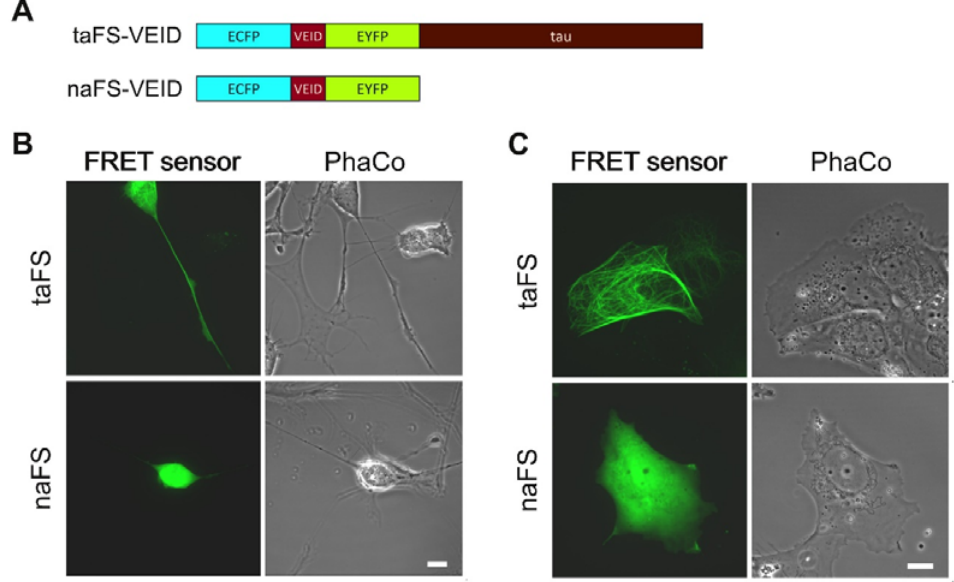
Figure 1. Anchoring enables monitoring of FRET sensors throughout the cell including thin processes. ( A ) Schematic illustration of an anchored (taFS-VEID) and a non-anchored (naFS-VEID) FRET sensors. Both sensors contain a tandem VEID sequence between ECFP and EYFP. naFS-VEID was generated by introducing a stop codon at the 5 ′ -end of tau-encoding sequence within the taFS-VEID cDNA; ( B ) Representative images of differentiated SH-SY5Y cells overexpressing taFS-VEID (upper panel) and naFS-VEID (lower panel); ( C ) Representative images of SK-N-AS cells overexpressing taFS-VEID (upper panel) and naFS-VEID (lower pannel). Note the absence of signal from taFS-VEID, but not naFS-VEID, in the nucleus. The epifluorecence images were linearly adjusted to display 0.1% saturated pixels. Scale bar 10 μ m.